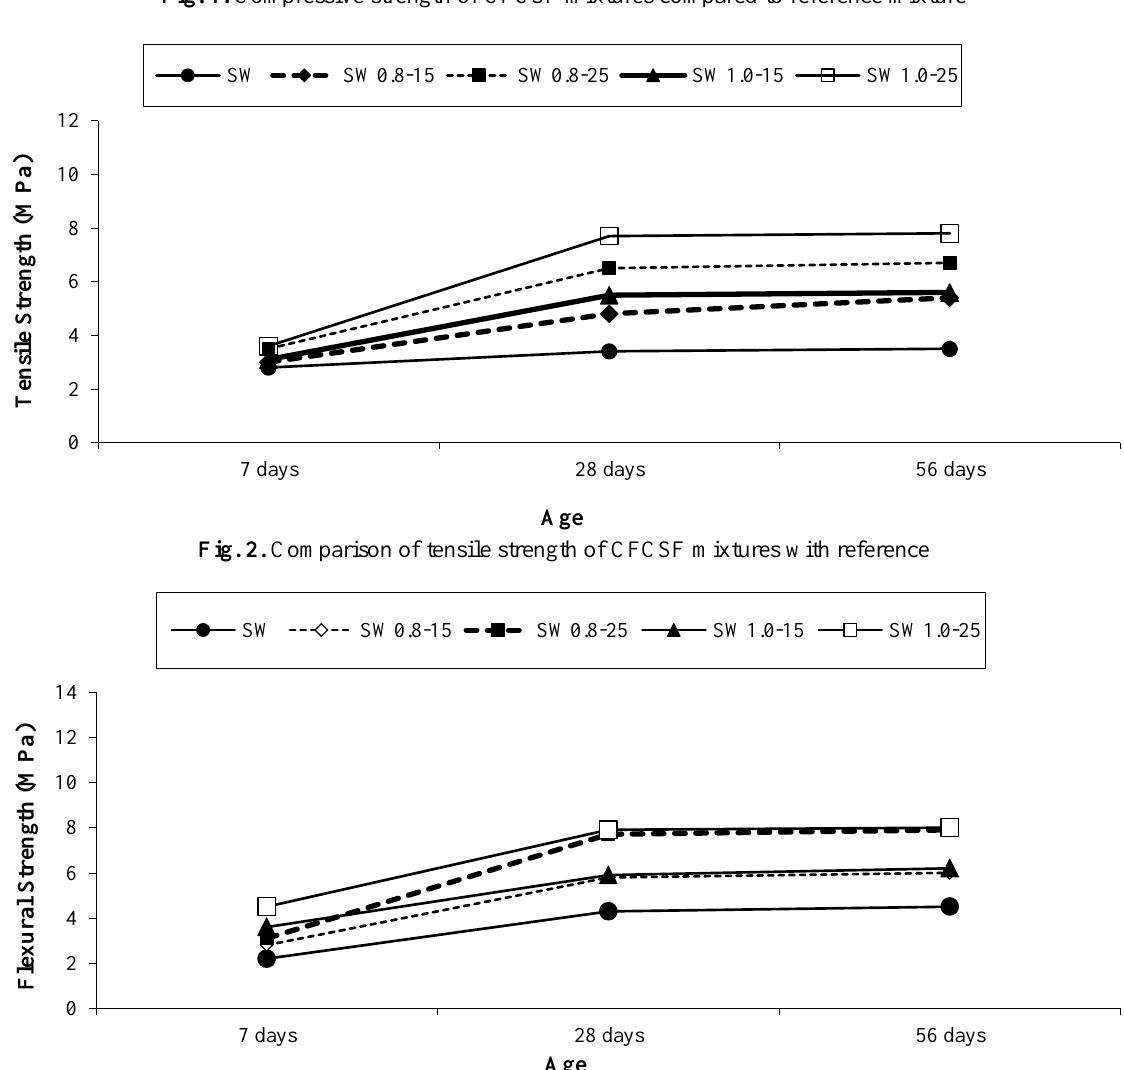
Fig. 1. Compressive strength of CFCSF mixtures compared to reference mixture